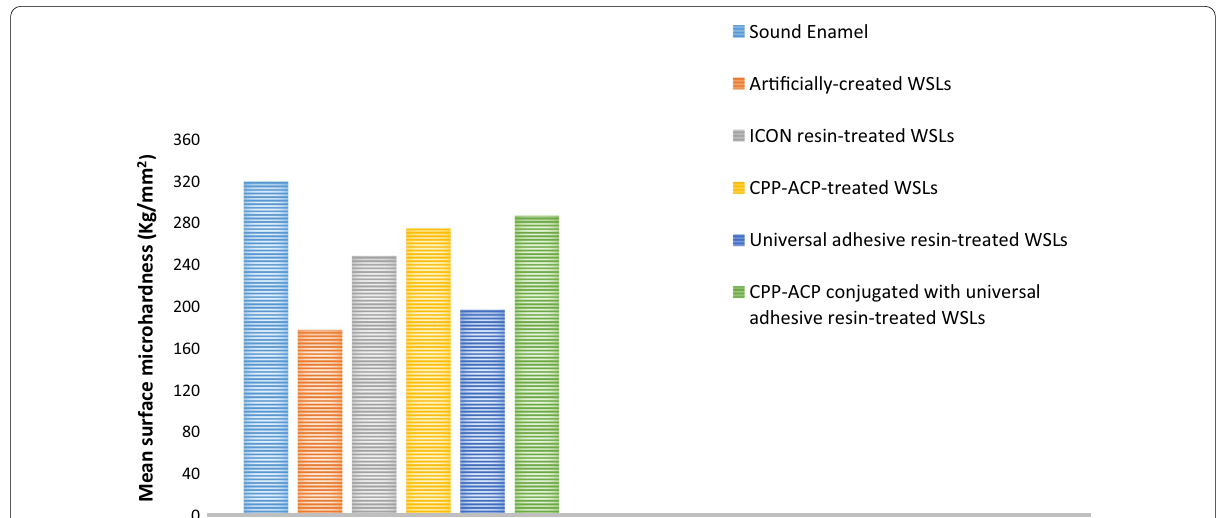
Fig. 3 Surface microhardness results of the investigated groups